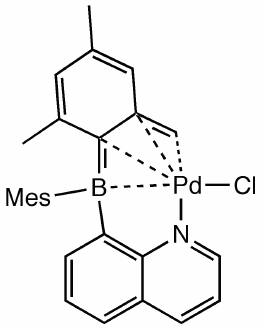
Figure 2. Chloro({2-[mesityl(quinolin-8-yl- κ N)boryl]-3,5-dimethylphenyl}methyl- κ C)-palladium(II) ( 9